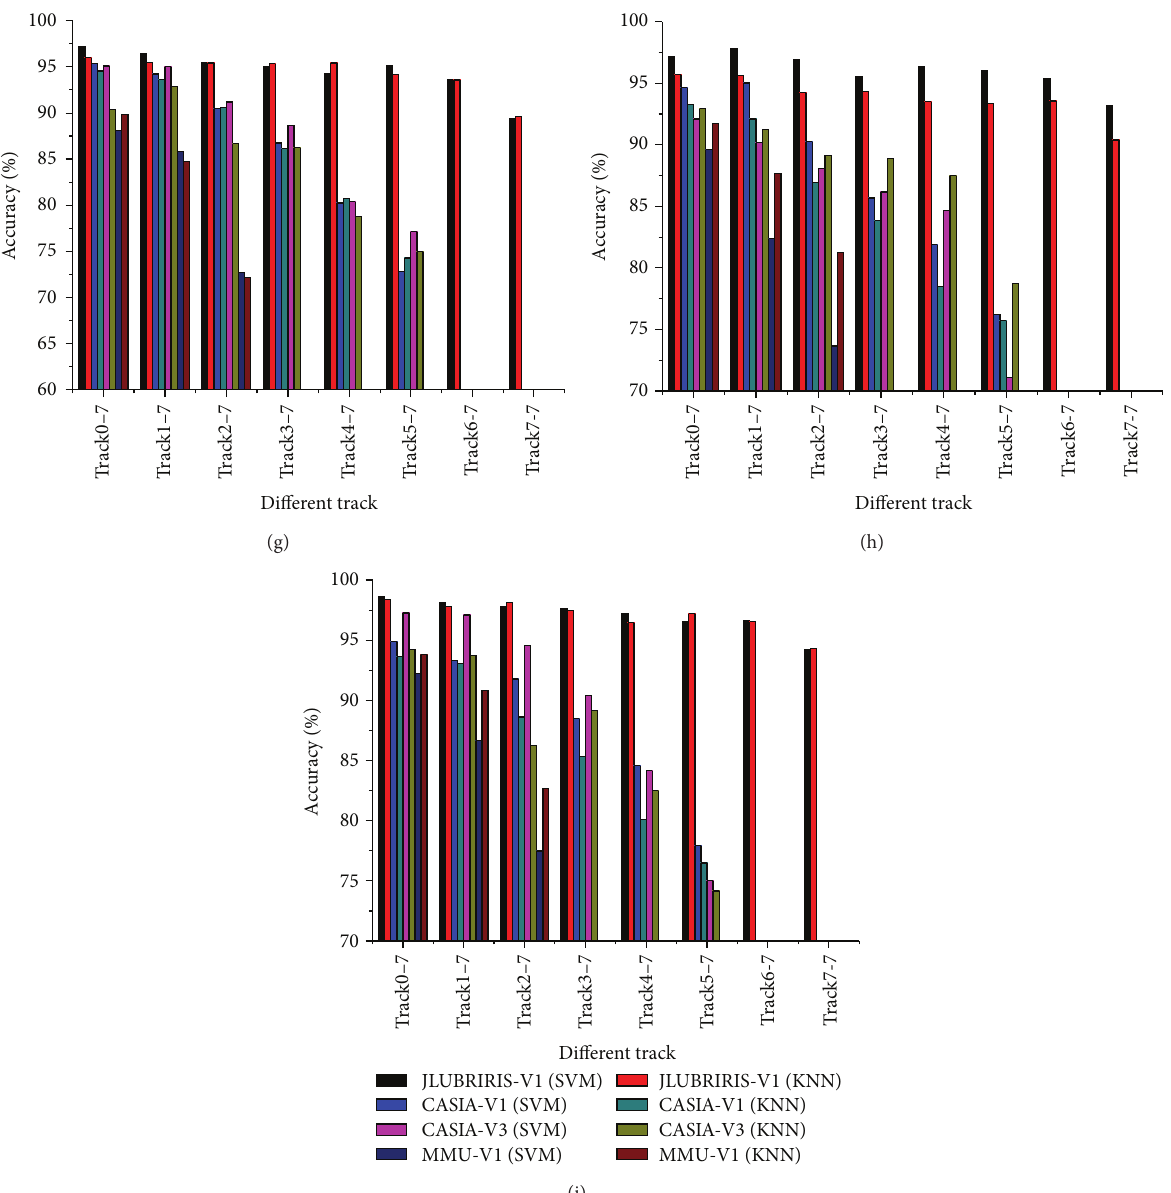
Figure 9: RAR of different tracks. (a) (b) (c) are experimental results of TestGroupOne , (a) is RAR produced by 2D Gabor features, (b) is RAR produced by GLCM features, and (c) is RAR produced by combined features. (d) (e) (f) are experimental results of TestGroupTwo , (d) is RAR produced by 2D Gabor features, (e) is RAR produced by GLCM features, and (f) is RAR produced by combined features. (h) (i) (j) are experimental results of TestGroupThree , (h) is RAR produced by 2D Gabor features, (i) is RAR produced by GLCM features, and (j) is RAR produced by combined